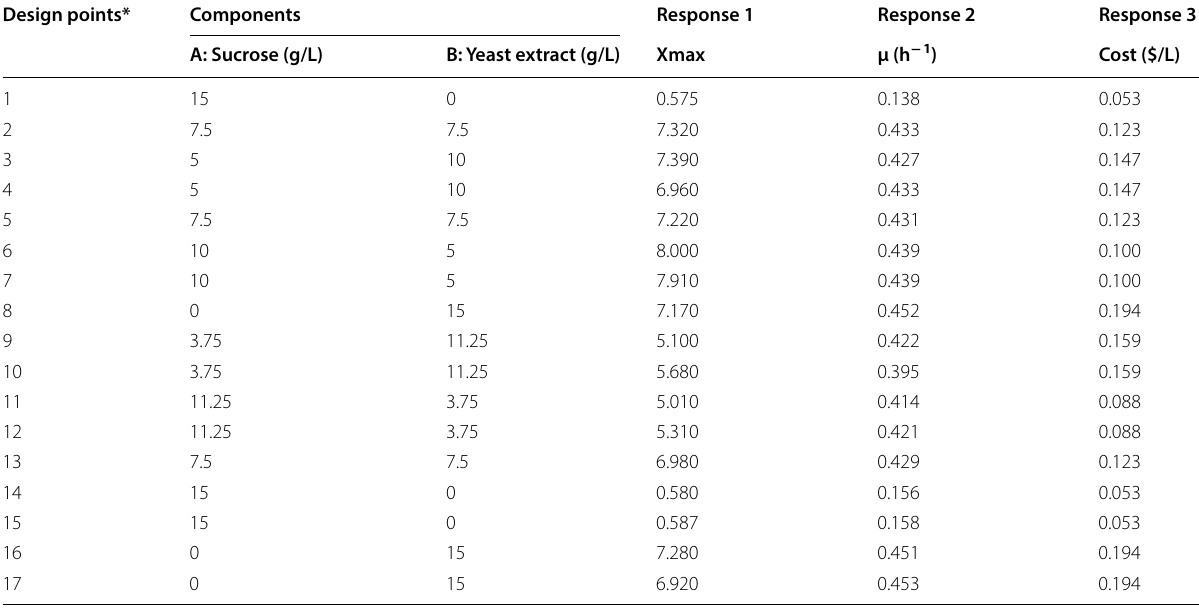
Table 2 Experimental design for optimization of culture medium concentration using I optimal mixture-design with corresponding observed values